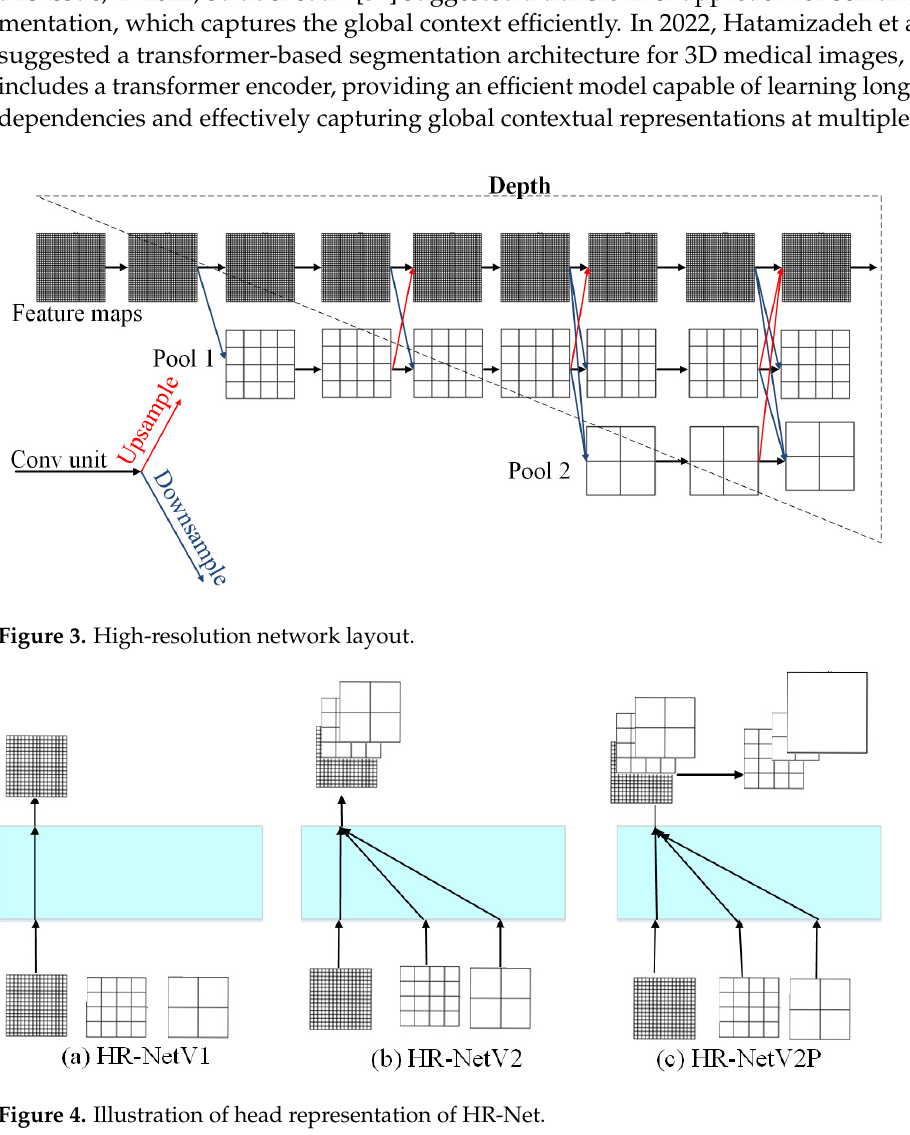
Figure 4. Illustration of head representation of